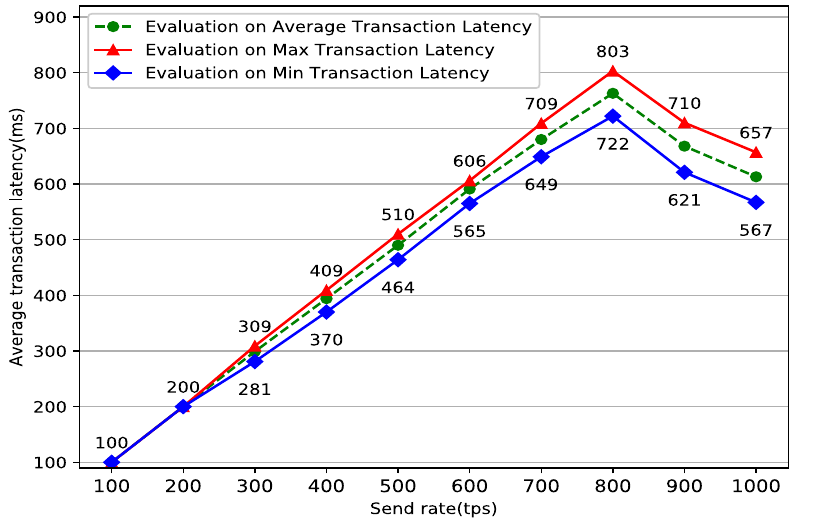
Figure 10. Evaluation on transaction latency.